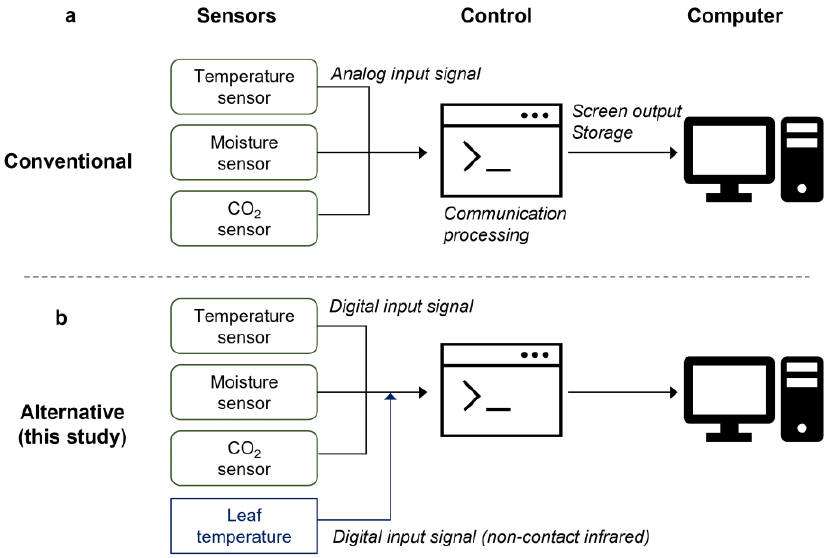
Figure 2. Conventional “smart farm” approaches used for sensor configuration, communication, and data management ( a ) and alternative approaches with the addition of leaf temperature monitoring ( b ).